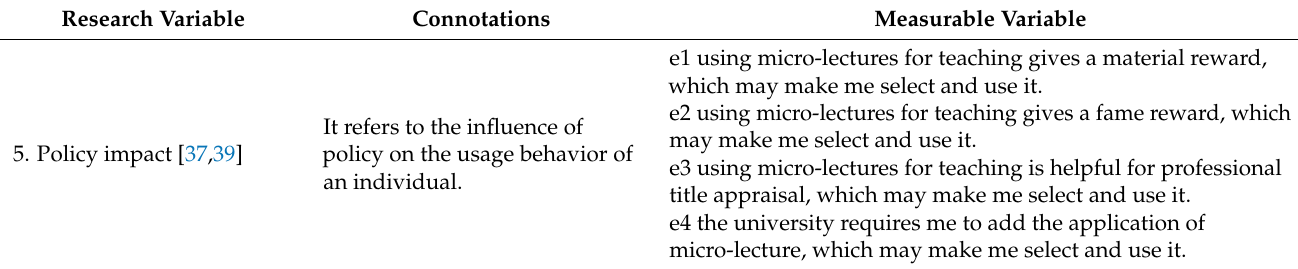
Table 7. Connotations and measurable variables of policy impact.